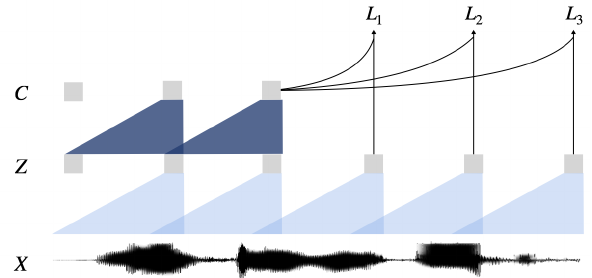
Figure 2. Overview of wav2vec: wav2vec uses two layers of CNNs stacked on top of each other to extract audio features from the original audio input X and predict the next-step information.